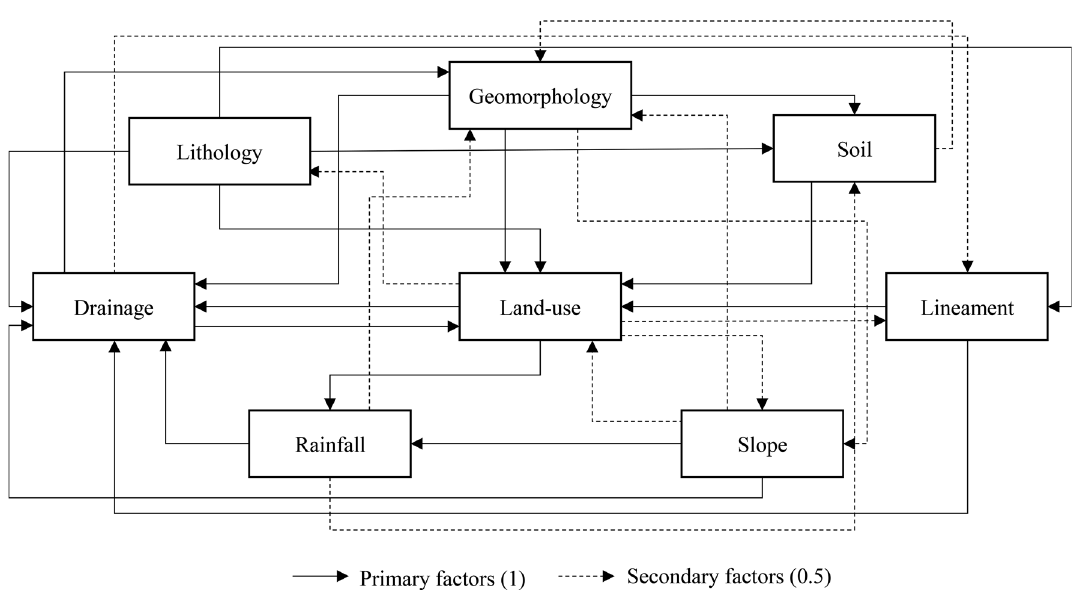
Fig. 3 Interrelationship between factors which influence groundwater potential. Source Modified after Magesh et al.